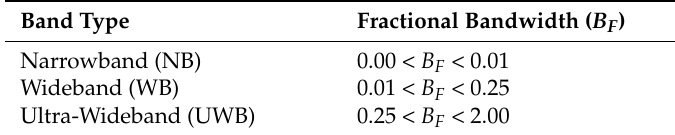
Table 1. The OSD/DARPA classification scheme for devices/signals based on